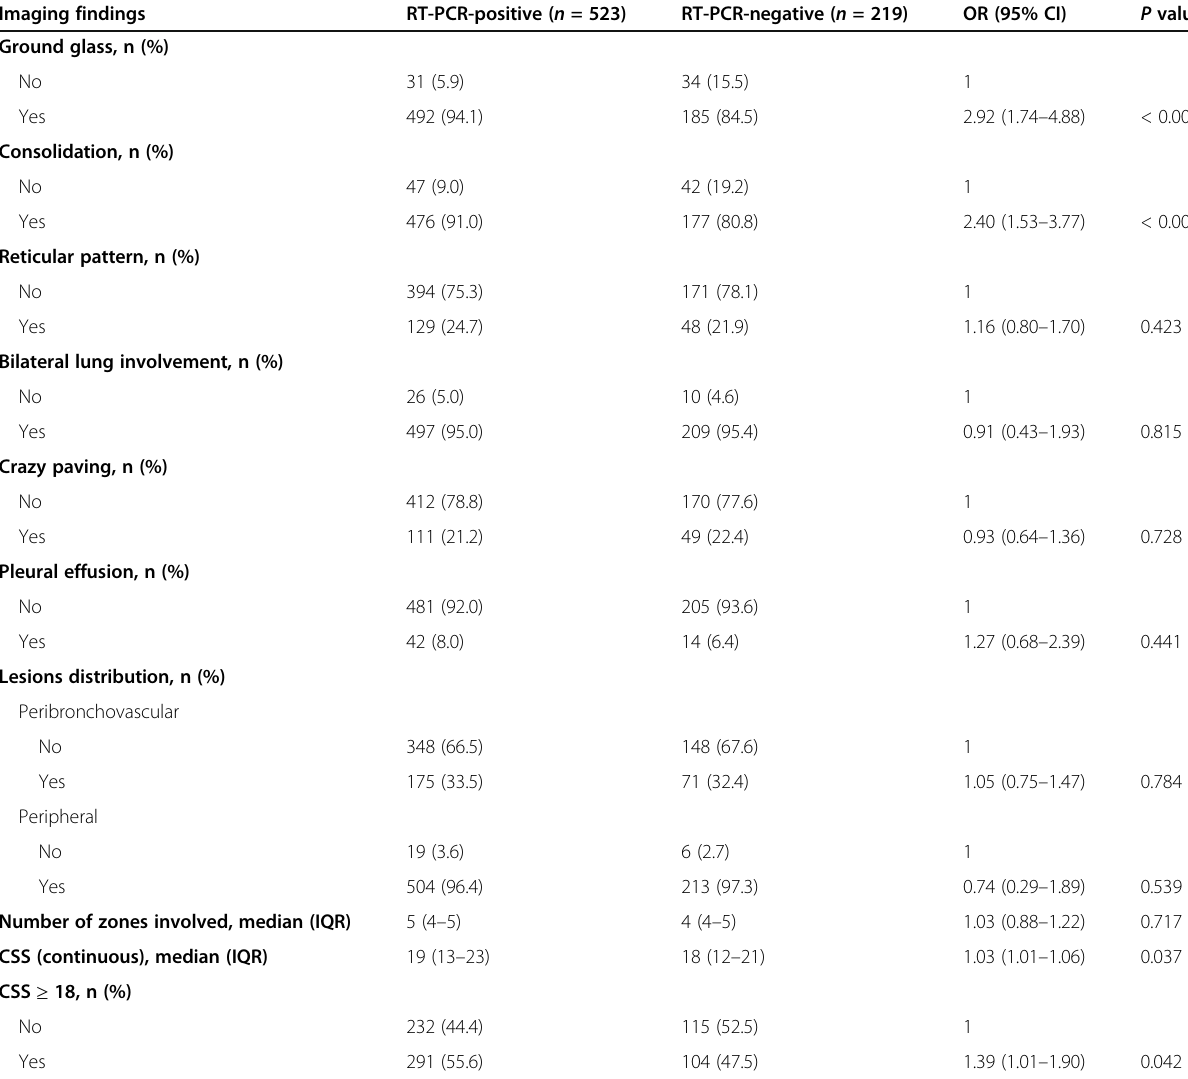
Table 2 Association between imaging findings and real-time polymerase chain reaction (RT-PCR) results Imaging findings RT-PCR-positive ( n = 523) RT-PCR-negative ( n = 219) OR (95%